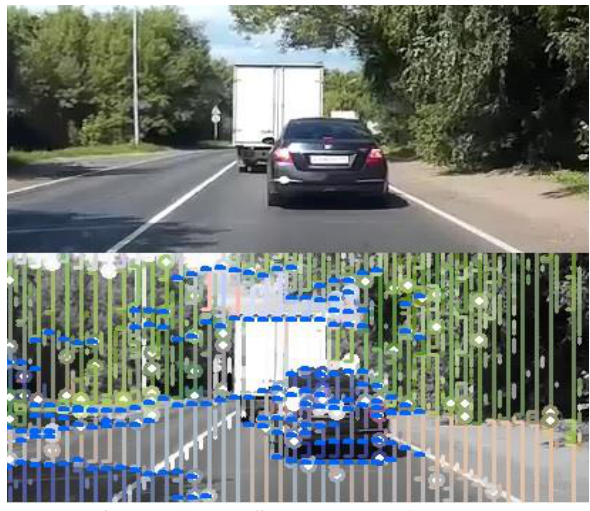
Figure 5 . “Almost” vertical lines of the image.